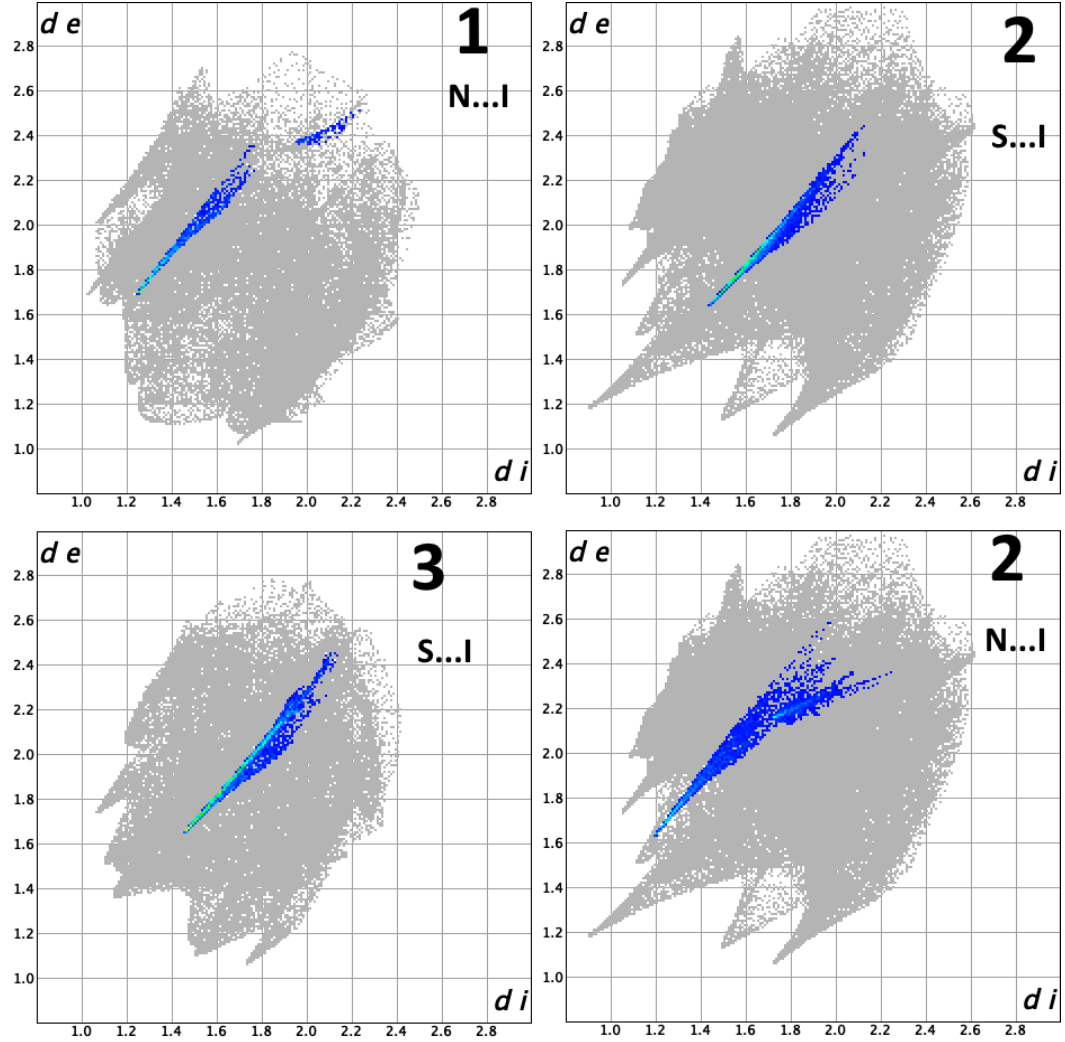
Figure 5. 2D fingerprint plots resolved into N ··· I in 1, S ··· I and N ··· I in 2, and S ··· I in 3. The full fingerprints appear in each plot as grey.